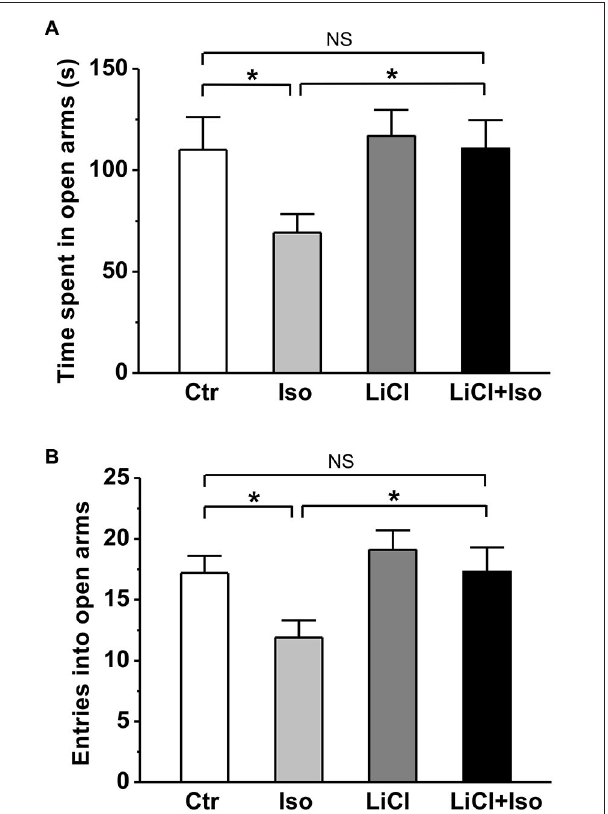
FIGURE 3 | Lithium reduces neonatal isolation-induced anxiety-like behavior in the elevated plus maze test . Both time spent in open arms (A) and the number of entries into open arms (B) are dramatically reduced in isolated rats during test, and lithium treatment rescues the impairment. Two-way ANOVA analysis was used in this experiment. For time spent in open arms: treatment × drug, F ( 1,96 ) = 1.354, P > 0.05; treatment, F ( 1,96 ) = 4.497, P < 0.05; drug, F ( 1,96 ) = 4.651, P < 0.05. For entries into open arms: treatment × drug, F ( 1,96 ) = 0.886, P > 0.05; treatment, F ( 1,96 ) = 5.134, P < 0.05; drug, F ( 1,96 ) = 5.389, P < 0.05. Data show mean ± SEM (* p < 0.05; ** p < 0.01).